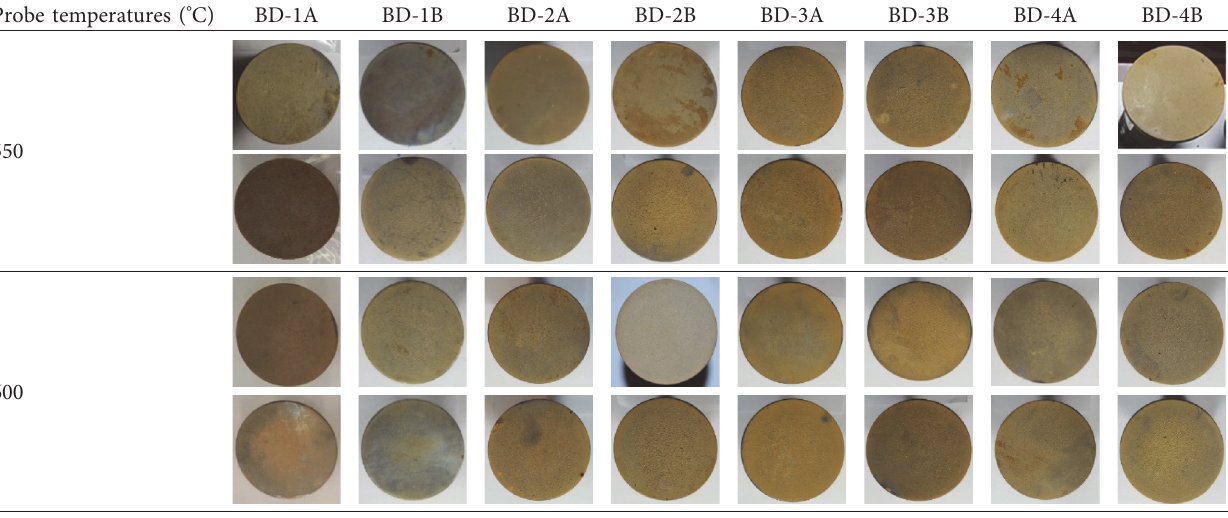
Table 4: Probe condition with dust and slag on DTF for each coal mixture with and without